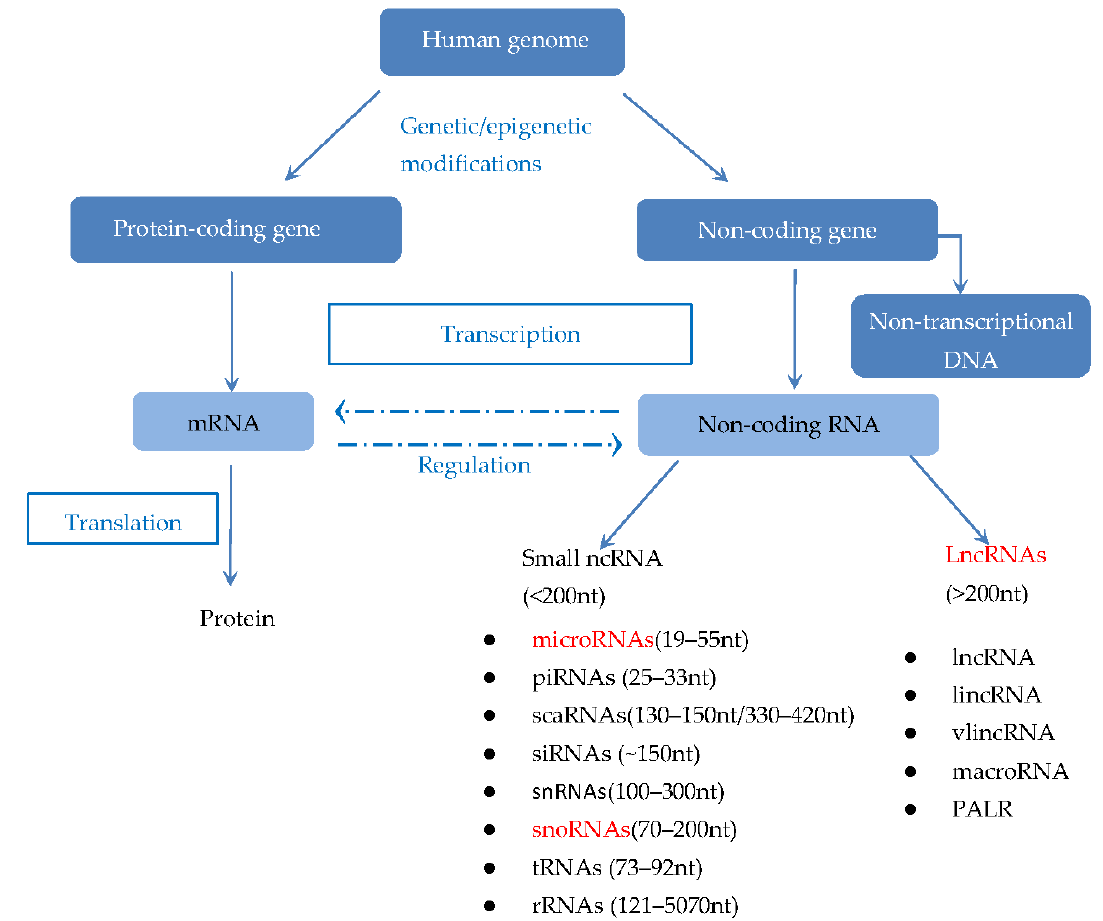
Figure 1. The construction of human genome [17–19]. The vast majority of human genome are composed of protein-coding sequences and noncoding sequences. The protein-coding sequences can be transcribed into messenger RNAs (mRNAs) and translated into proteins ultimately, whereas, the nonprotein-coding gene can be transcribed in (functional) noncoding RNAs (ncRNAs) which can be classified in long ncRNAs (lncRNAs) and small ncRNAs based on their size and function. Small ncRNAs comprise microRNAs (miRNAs), piwi-interacting RNAs (piRNAs), ribosomal RNAs (rRNAs), small Cajal body-specific RNAs (scaRNAs), small-interfering RNAs (siRNAs), small nuclear RNAs (snRNAs), small nucleolar RNAs (snoRNAs), and transfer RNAs (tRNAs). Furthermore, tRNAs, rRNAs, snRNAs and snoRNAs belong to the well-characterized housekeeping ncRNAs; miRNAs can also be derived from lncRNAs and snoRNAs (highlighted in red). LncRNAs are mainly classified into lncRNA, lincRNA (long-intergenic non-coding RNA; large intervening non-coding RNA, long-intervening non-coding RNA), vlincRNA (very long intergenic non-coding RNA), macroRNA and promoter-associated long RNA (PALR). In addition, there is a portion of genome that is not transcribed. Adapted from [18].